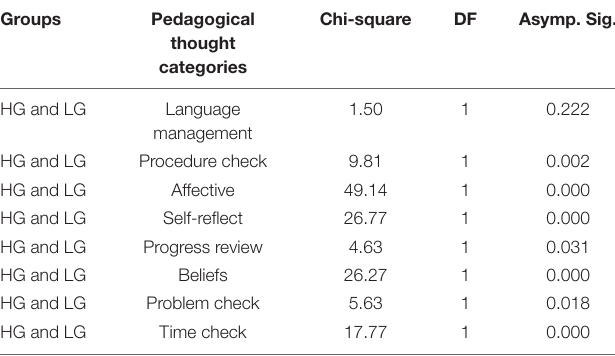
TABLE 2 | The edited table of Chi-square results for differences in the PTUs within the dominant PTCs.